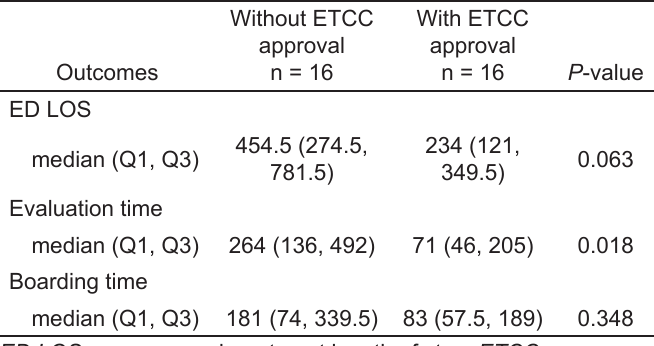
ED LOS, emergency department length of stay; ETCC, emergency transfer coordination